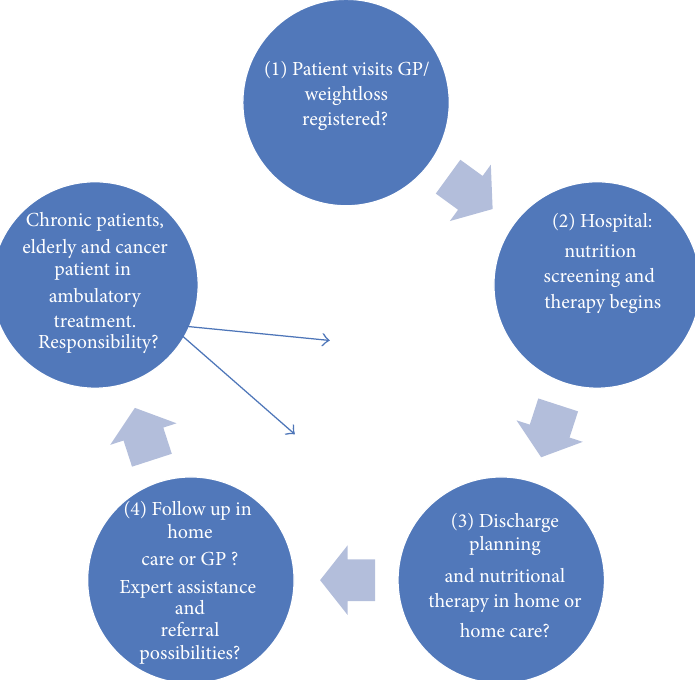
Figure 1: Flow chart for the patient course of the nutritional risk